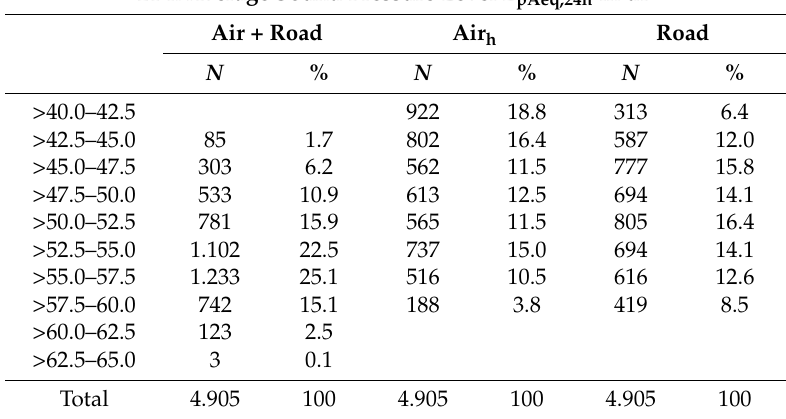
Table 1. Number of respondents in each sound class of the average sound pressure level aircraft + road traffic, aircraft and road traffic noise.